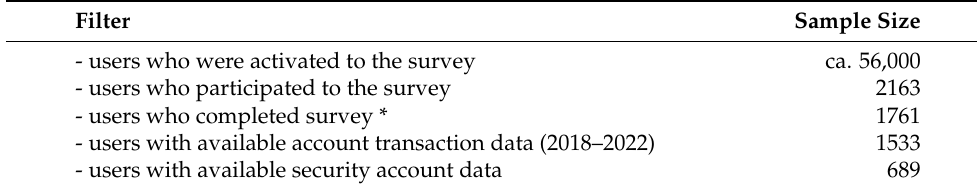
Figure A1. Survey participation of completed surveys over time. Source: Own data. Table A1. Number of cases. Source: Own data.